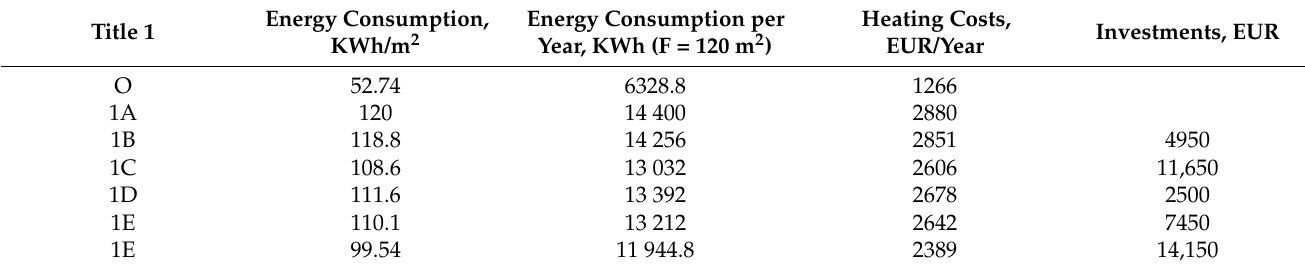
Table 3. Energy consumption and costs for different